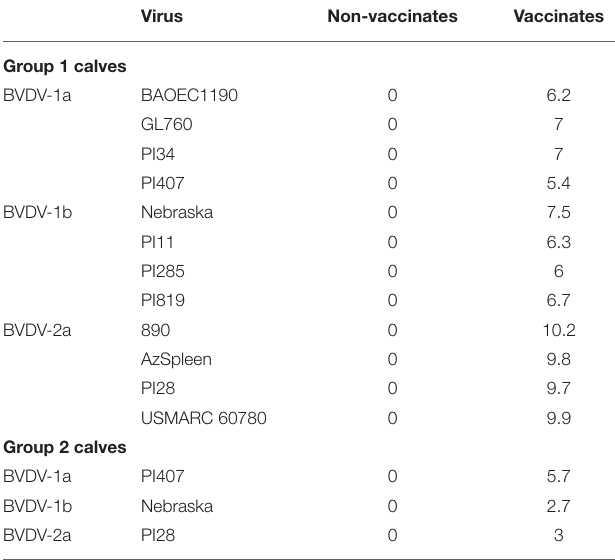
TABLE 3 | Average virus neutralization titers (log2 transformed) from sera from vaccinated and non-vaccinated calves from Group 1 and 2 against BVDV 1a, 1b and 2a